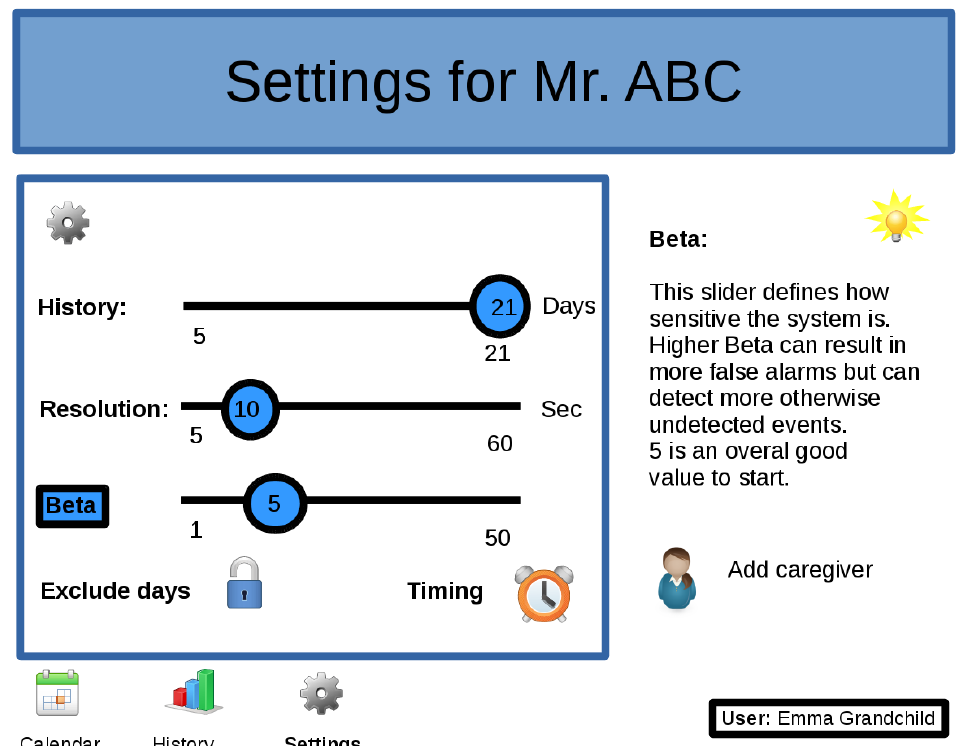
Figure 11. Example of a dashboard settings page. Starting from default settings, the user can easily fine-tune detection levels, exclude certain days and define the times when analysis should be